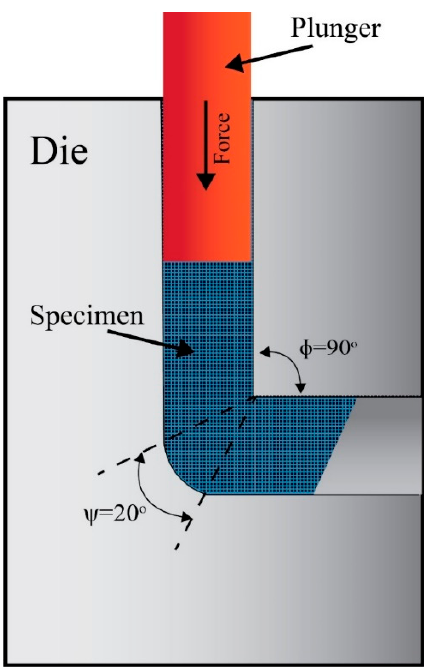
Figure 1. The schematic of the equal channel angular pressing (ECAP) die. To characterize the microstructural evolution, an as-annealed alloy and ECAP-processed billets were used. Samples were cut along their longitudinal cross-section, and grinded, polished, and etched in a solution of 6 g picric acid, 5 mL acetic acid (95%), 10 mL water, and 100 mL ethanol for 50 s (according to ASTM, E407-07). The microstructural evolution of the AZ31 billets before and after ECAP processing was characterized using an optical microscopy (OM) (Qualitest, Nisku, Canada), which was equipped with Vision Lite & PE 8.0 advanced image analysis software (Clemex Technologies Inc., Vision Lite & PE 8.0, Longueuil, Canada) and a scanning electron microscope (SEM,) of type JSM-IT300 InTouchScope™ in combination with an X-MaxN Oxford energy dispersive X-ray spectroscopy EDS analyzer (Joel Ltd., Tokyo, Japan).